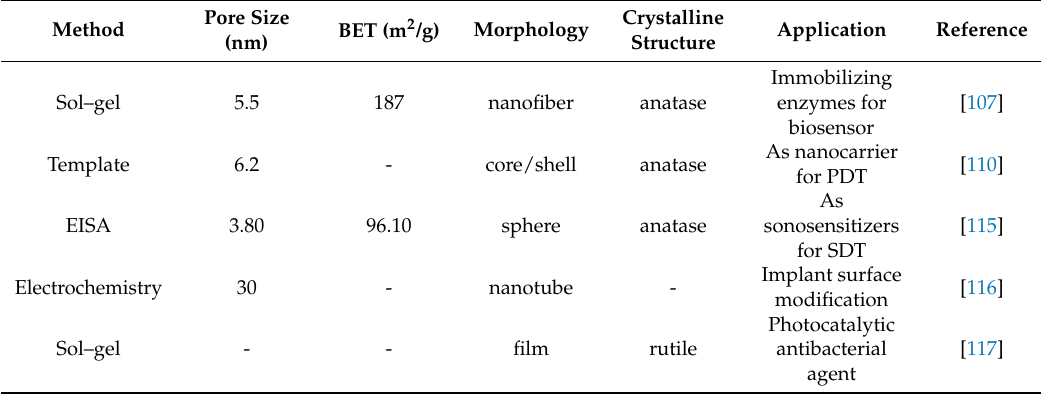
Table 5. Specific biological applications of mesoporous TiO 2